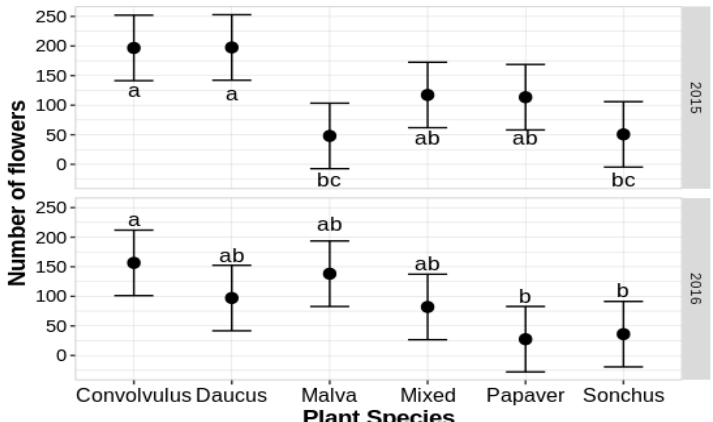
Figure 3. Differences between treatments in the average number of flowers in both years of the study (2015 and 2016). Values are the estimated marginal means from the general mixed-effects model. Bars show confidence intervals at the 0.95 level. Letters indicate differences between treatments derived from post hoc pairwise comparisons using the Tukey method for p -value adjustment. Contrasts were performed between treatments and for each year separately. Flower species are indicated by genus.